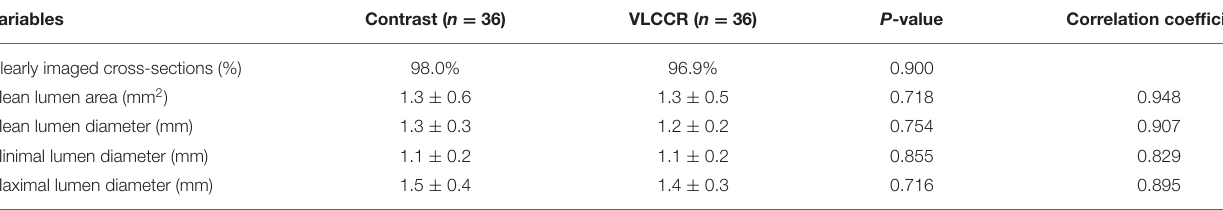
TABLE 3 | Comparison of OCT imaging performed using contrast vs. VLCCR.